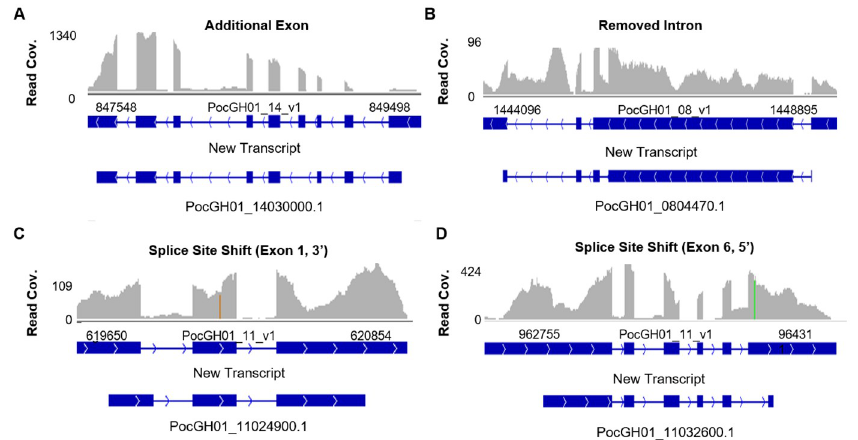
Fig 2. Examples of different splicing patterns in P . ovale clinical isolate. (A) New transcript identified with additional exon toward the center of PocGH01_14030000. (B) A missing intron in some transcripts of PocGH01_0804470. (C) A shift in splicing point resulting in a shorter intron for PocGH01_11024900. (D) A shift in splicing point resulting in a longer exon in PocGH01_11032600. For each the first panel represents read density, the second represents transcript